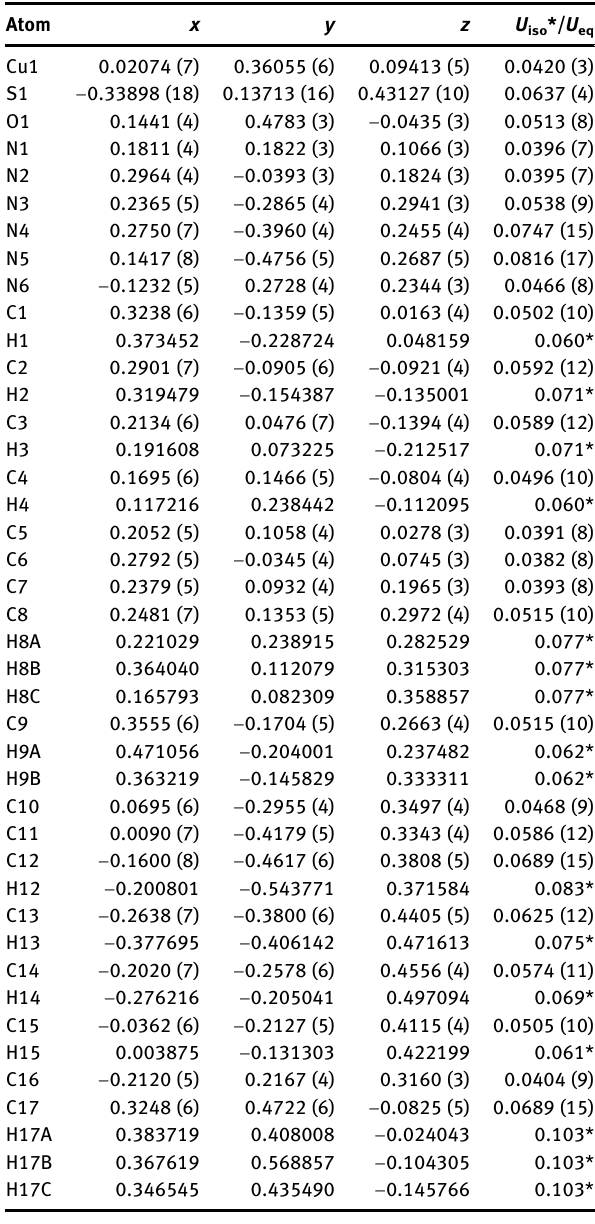
Table  : Fractional atomic coordinates and isotropic or equivalent isotropic displacement parameters (Å 